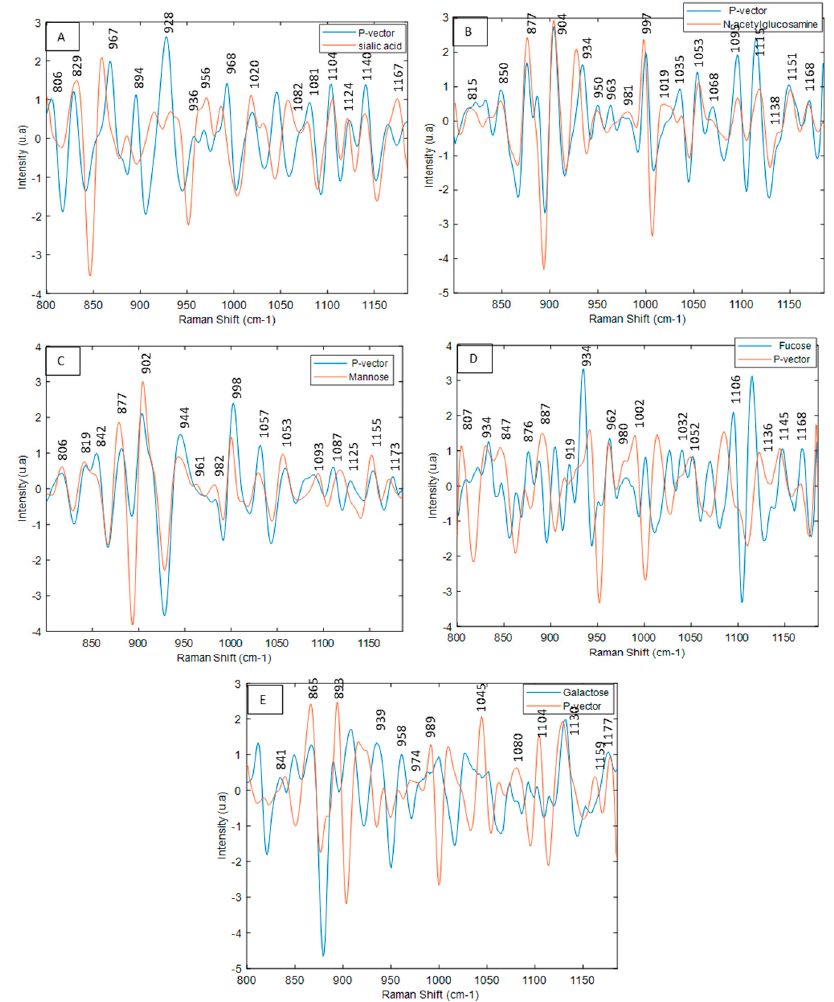
Figure 11. Superimposition of the P-vector with each respective monosaccharide. ( A ) Sialic acid SVR model. ( B ) N-acetylglucosamine SVR model. ( C ) Mannose SVR model. ( D ) Fucose SVR model. ( E ) Galactose SVR model.